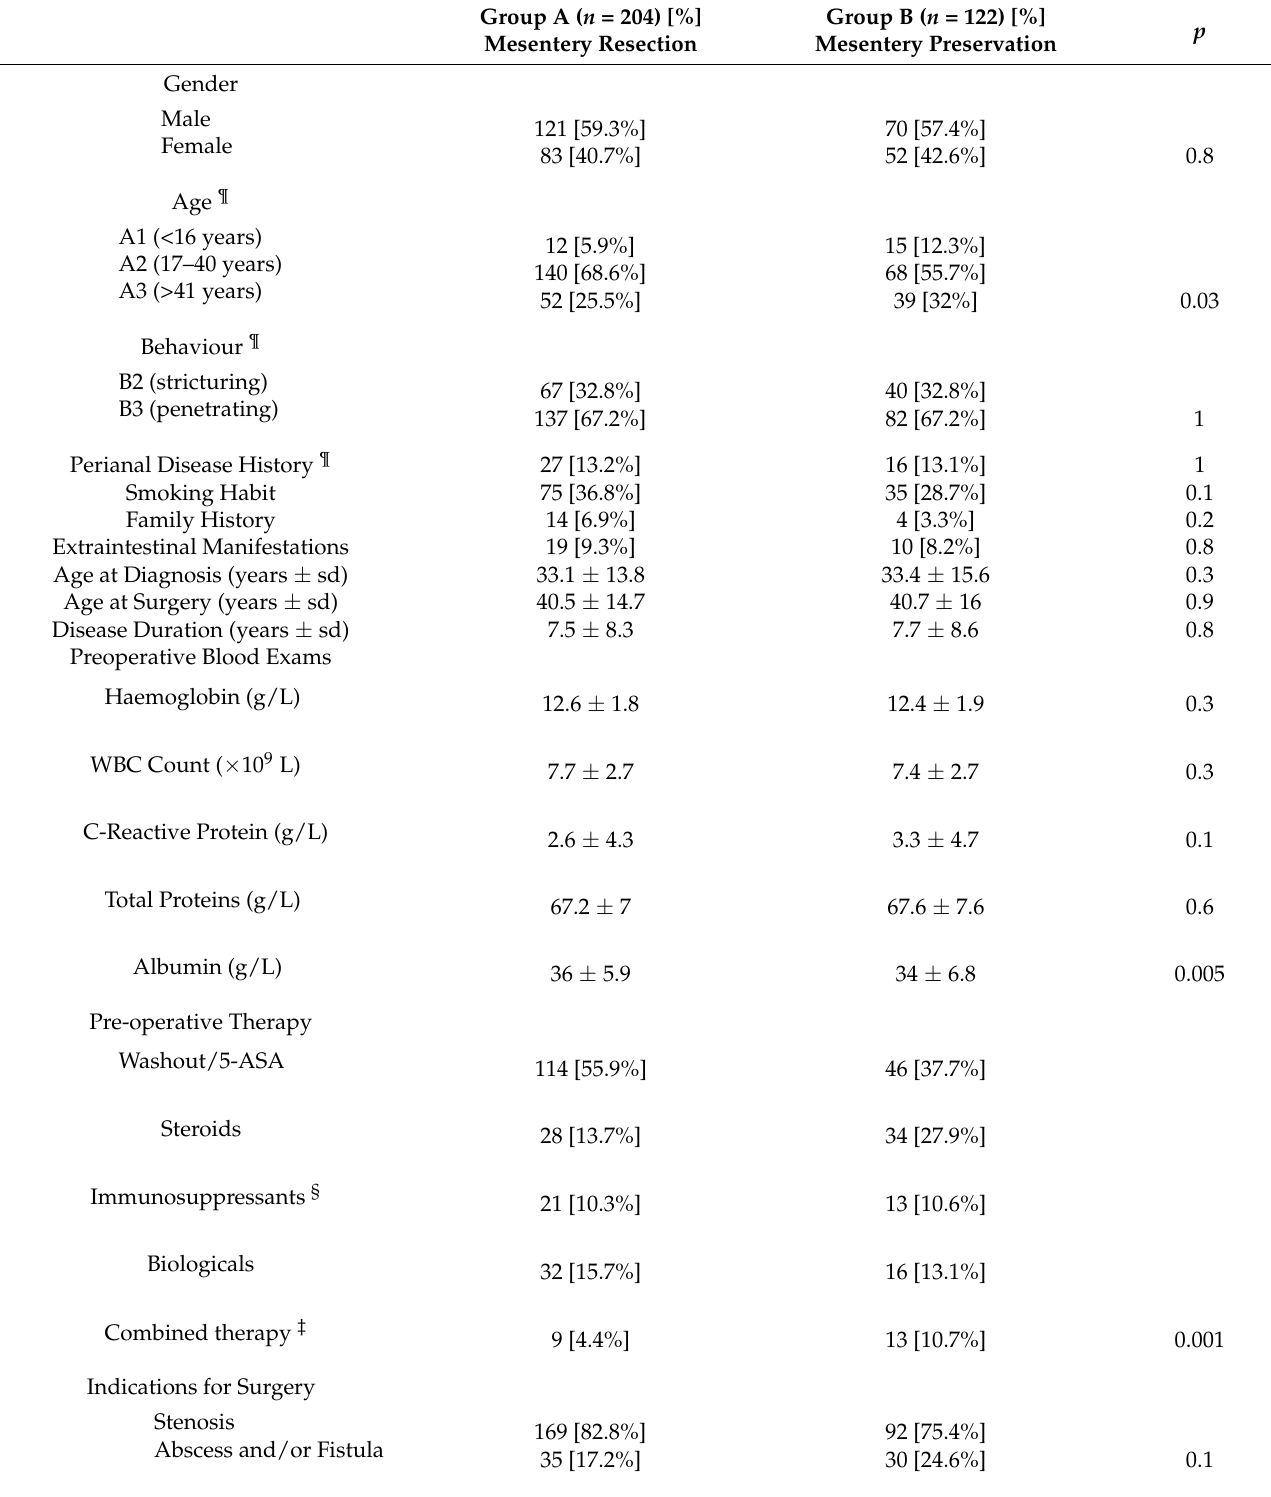
Table 1. Patients’ history and characteristics. ¶ Montreal Classification for CD. § Azathioprine, 6-Mercaptopurine, or Methotrexate. ‡ Any combination of steroids with biologicals or immunosup-